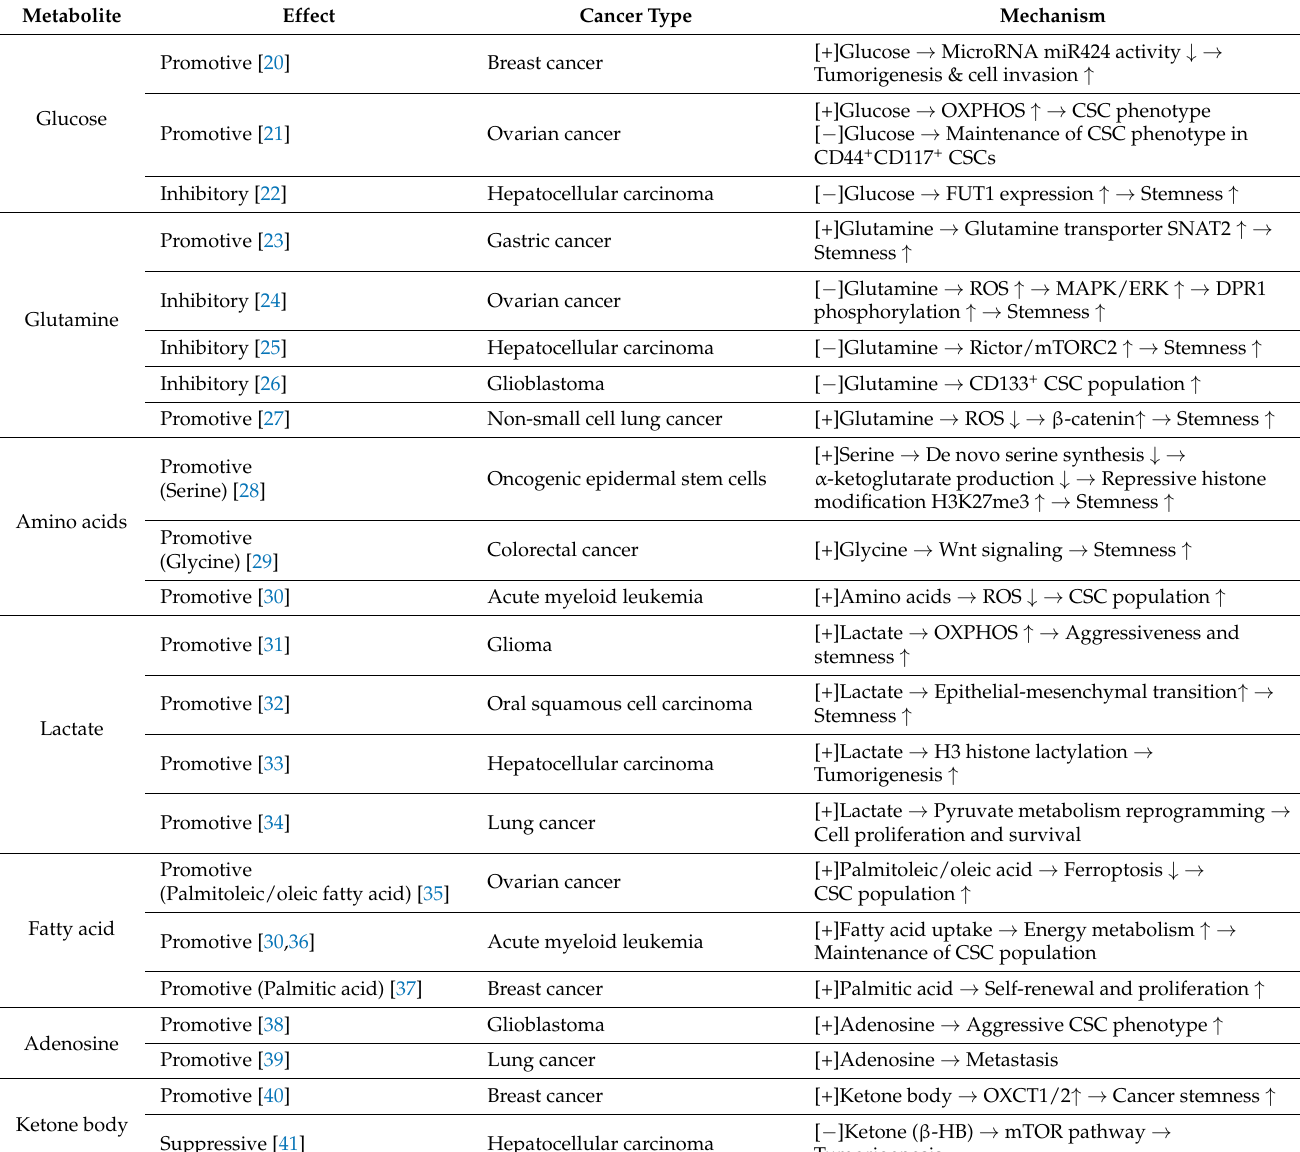
Table 1. The effect and regulation of extracellular metabolites on cancer stemness in different